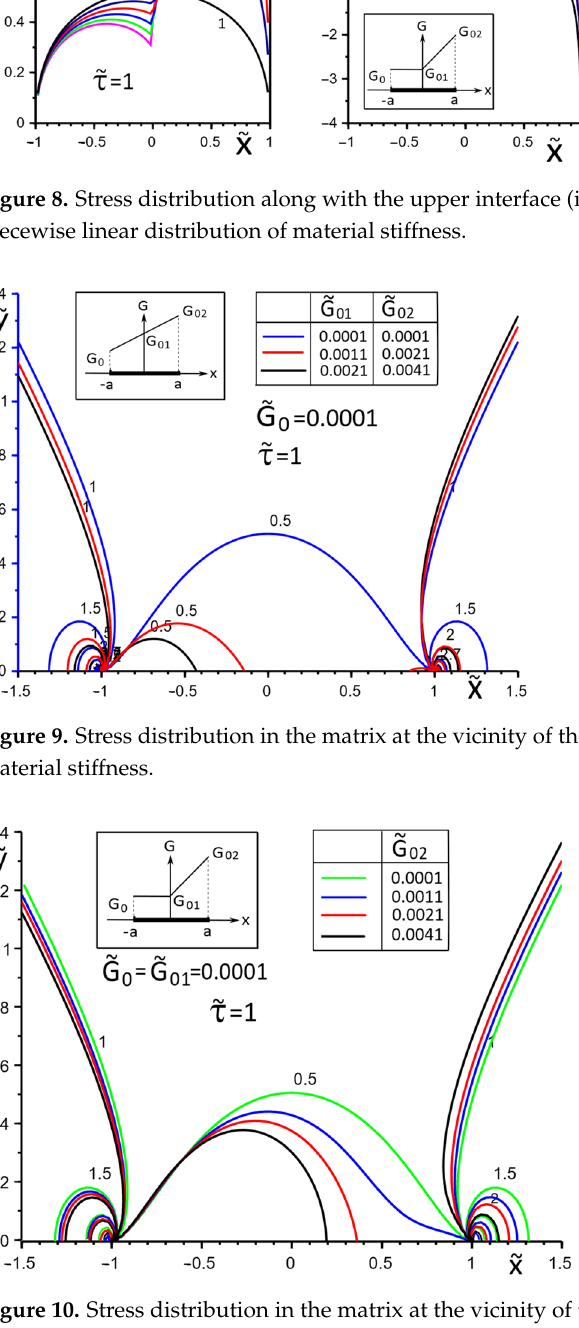
Figure 10. Stress distribution in the matrix at the vicinity of the inclusion with the piecewise linear distribution of material stiffness.